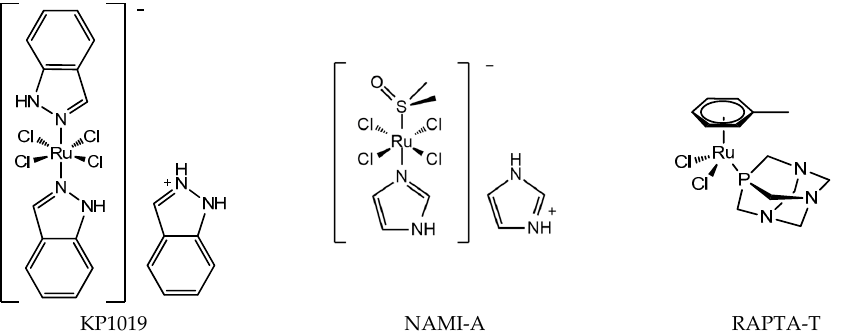
Figure 2. Chemical structure of ruthenium anticancer drugs: Ru III compounds indazolium trans -